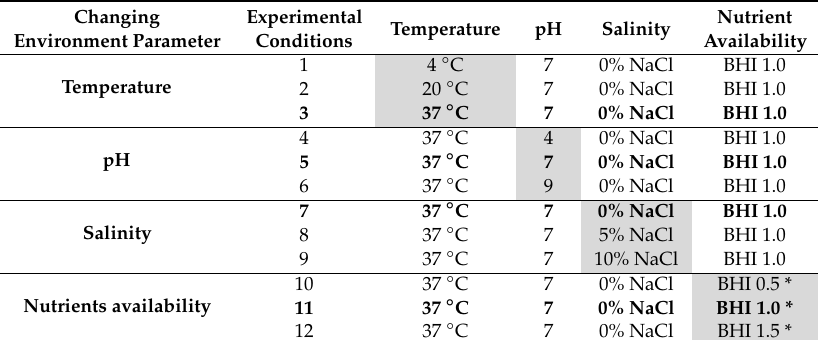
Table 8. Experimental conditions used in the study.